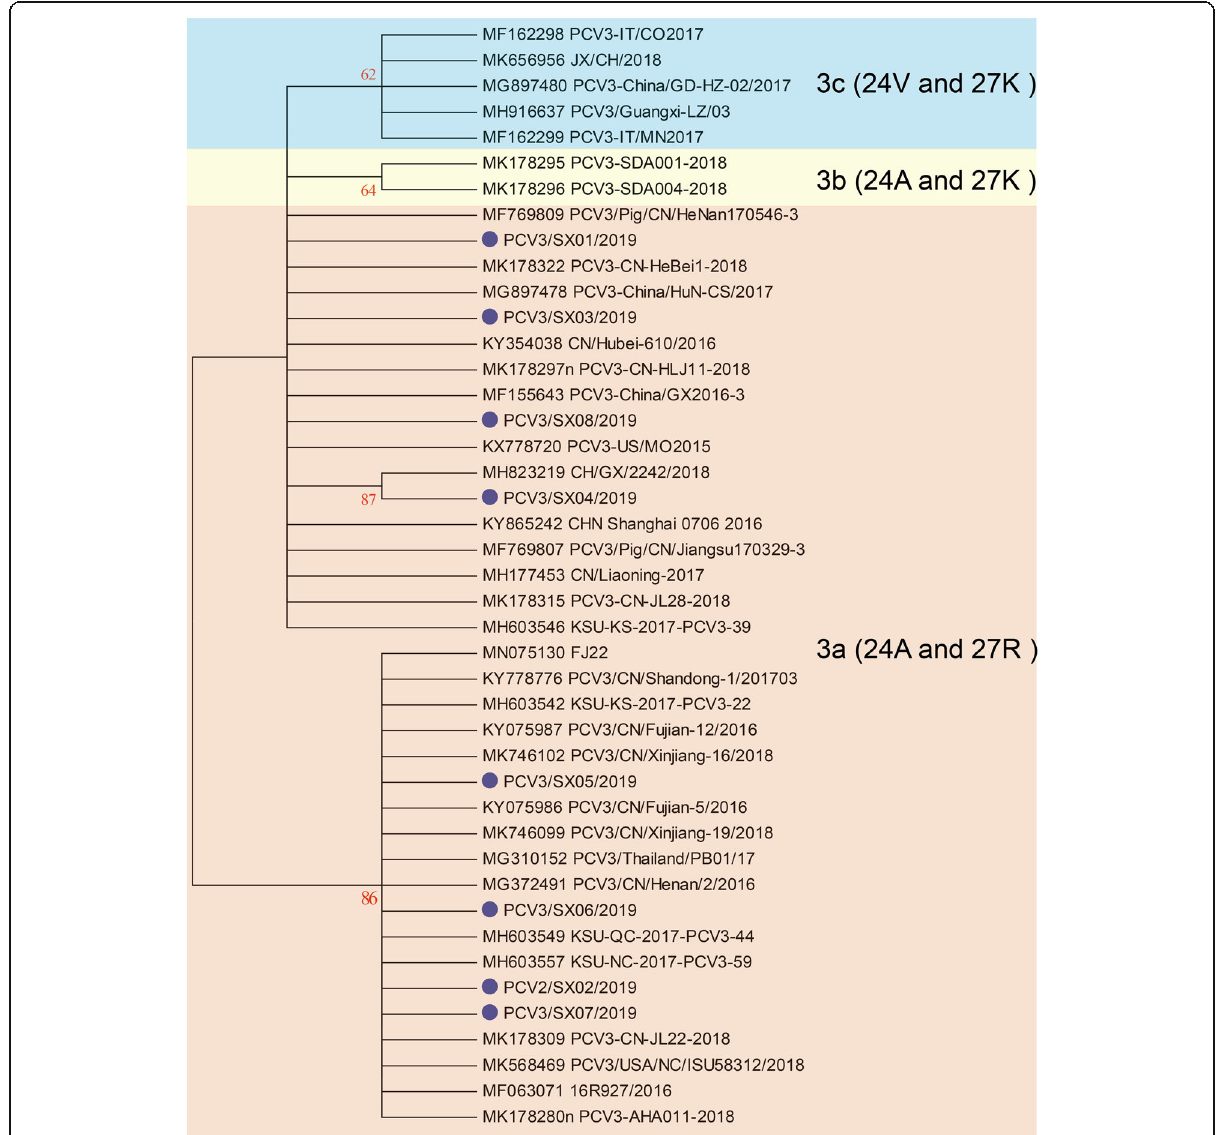
Fig. 4 Phylogenetic tree and amino acid alignment based on the Cap encoding gene of 35 porcine circovirus type 3 (PCV3) strains. PCV3 strains clustered into 3 subgroups, namely, 3a, 3b, and 3c. Blue dots indicate PCV3 strains investigated in this